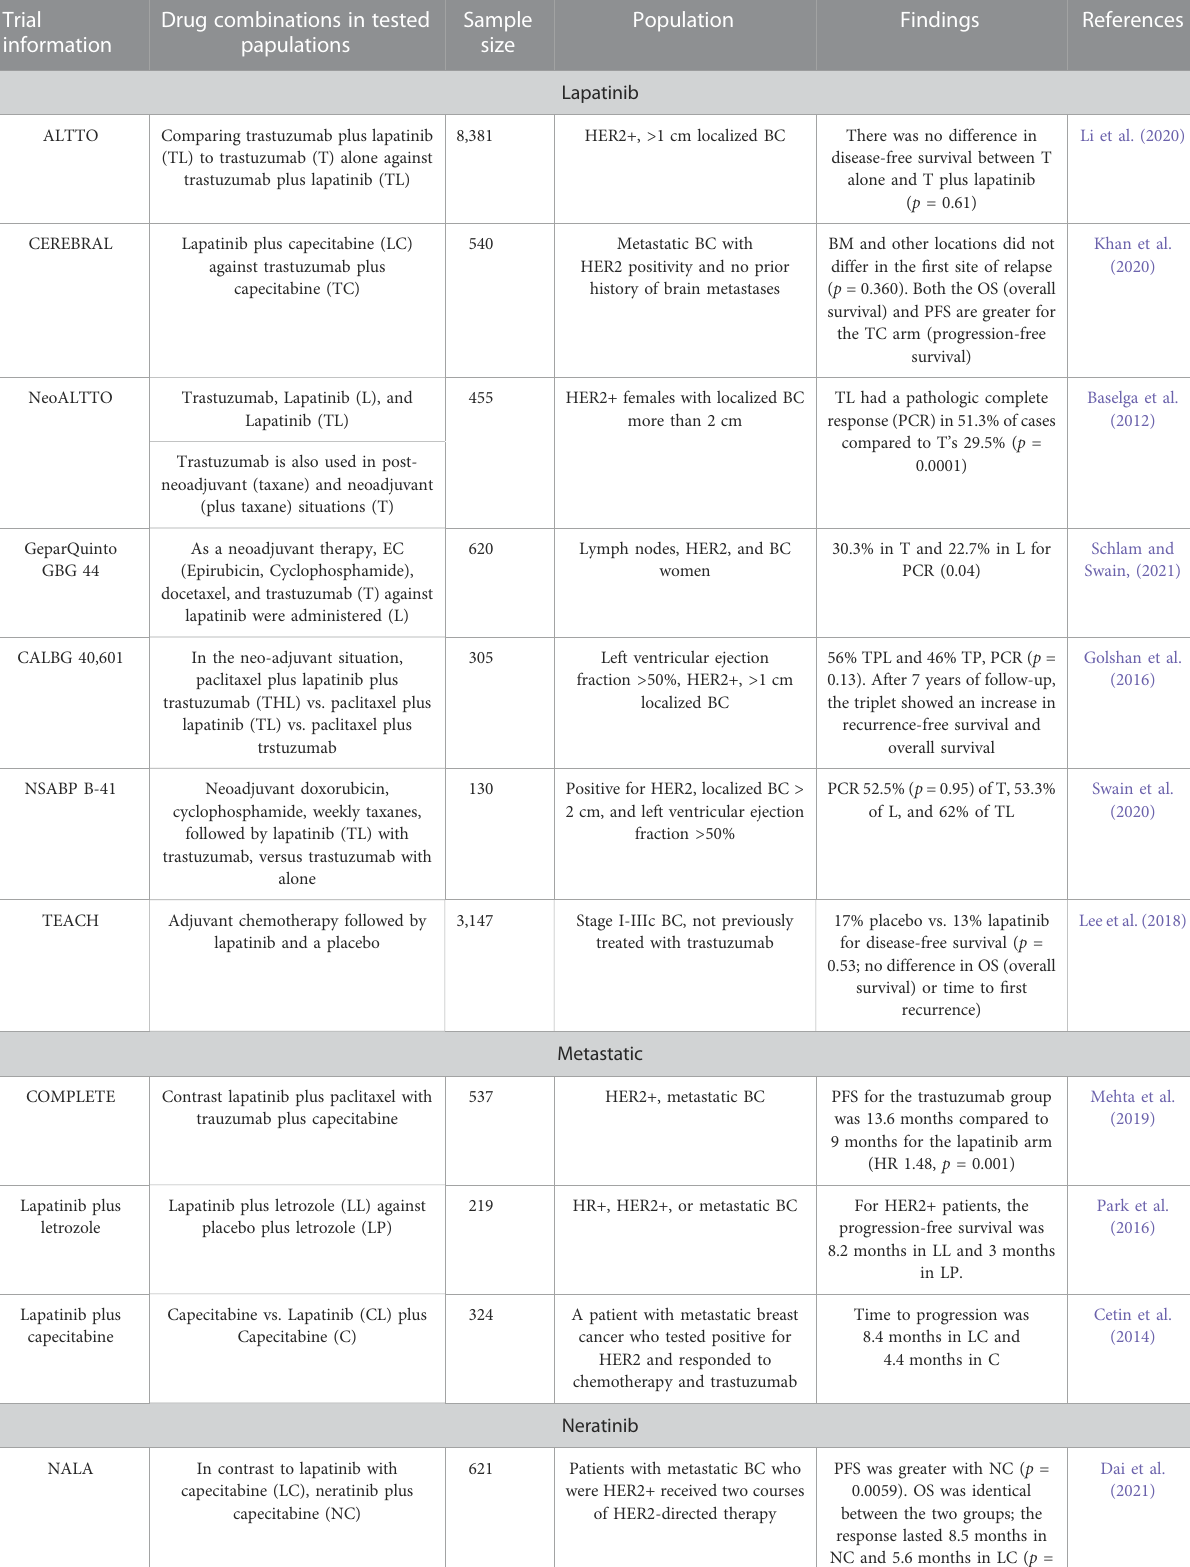
TABLE 1 HER2-targeted TKIs are being studied in key phase 3 clinical trials in breast